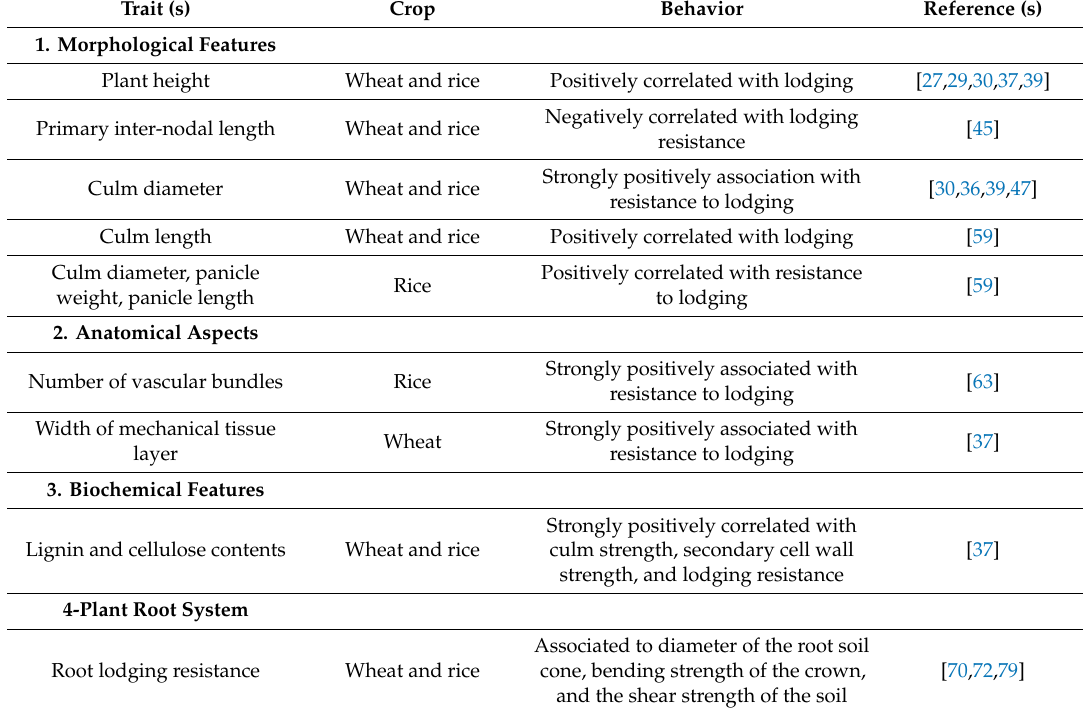
Table 1. Plant constituents associated with lodging resistance in wheat and